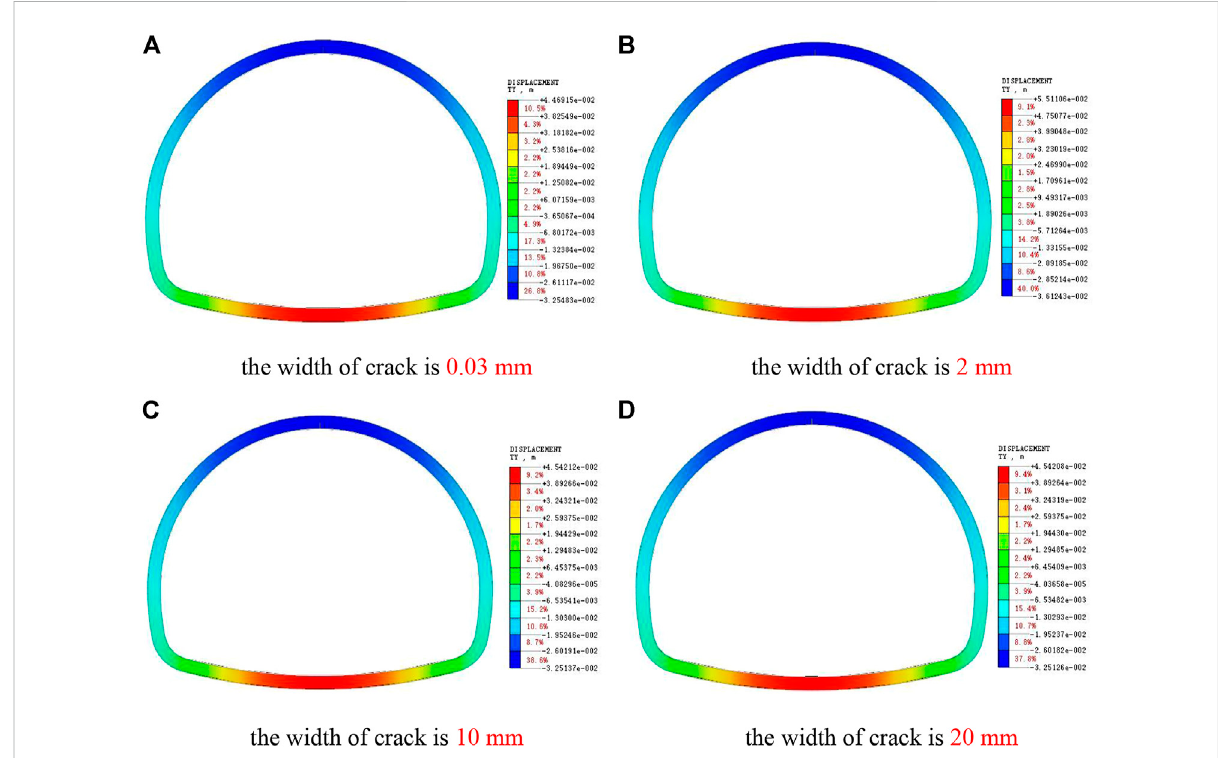
FIGURE 13 Cloud pictures of Y-direction displacement of side wall crack lining. (A) The width of crack is 0.03 mm. (B) The width of crack is 2 mm. (C) The width of crack is 10 mm. (D) The width of crack is 20